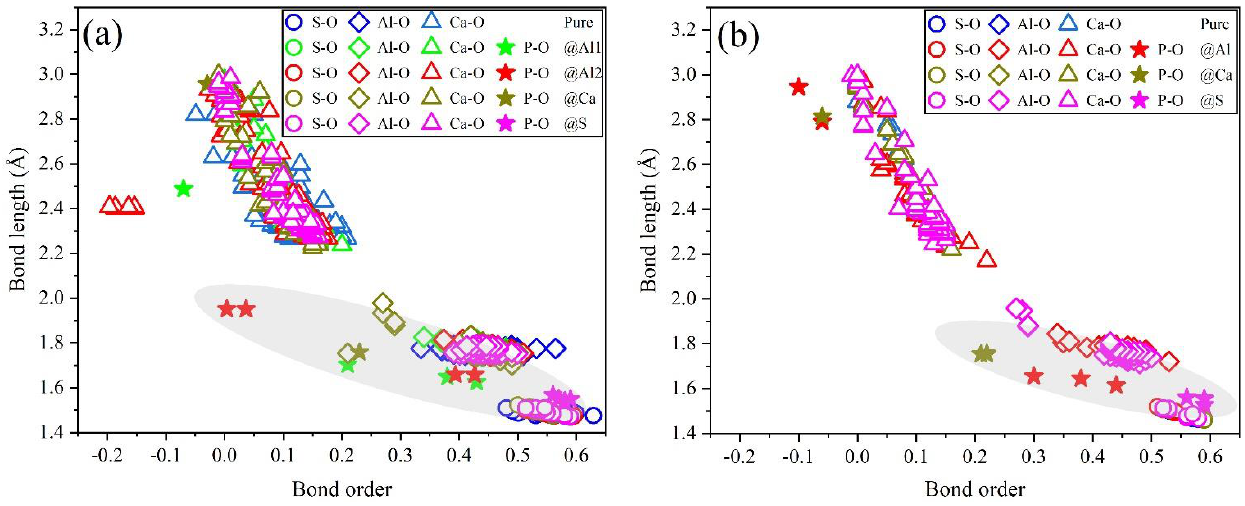
Figure 9. Distributions of BL – BO in pure and P- doped ye’elimite with different configurations: ( a ) P@ST and ( b ) P@SS.